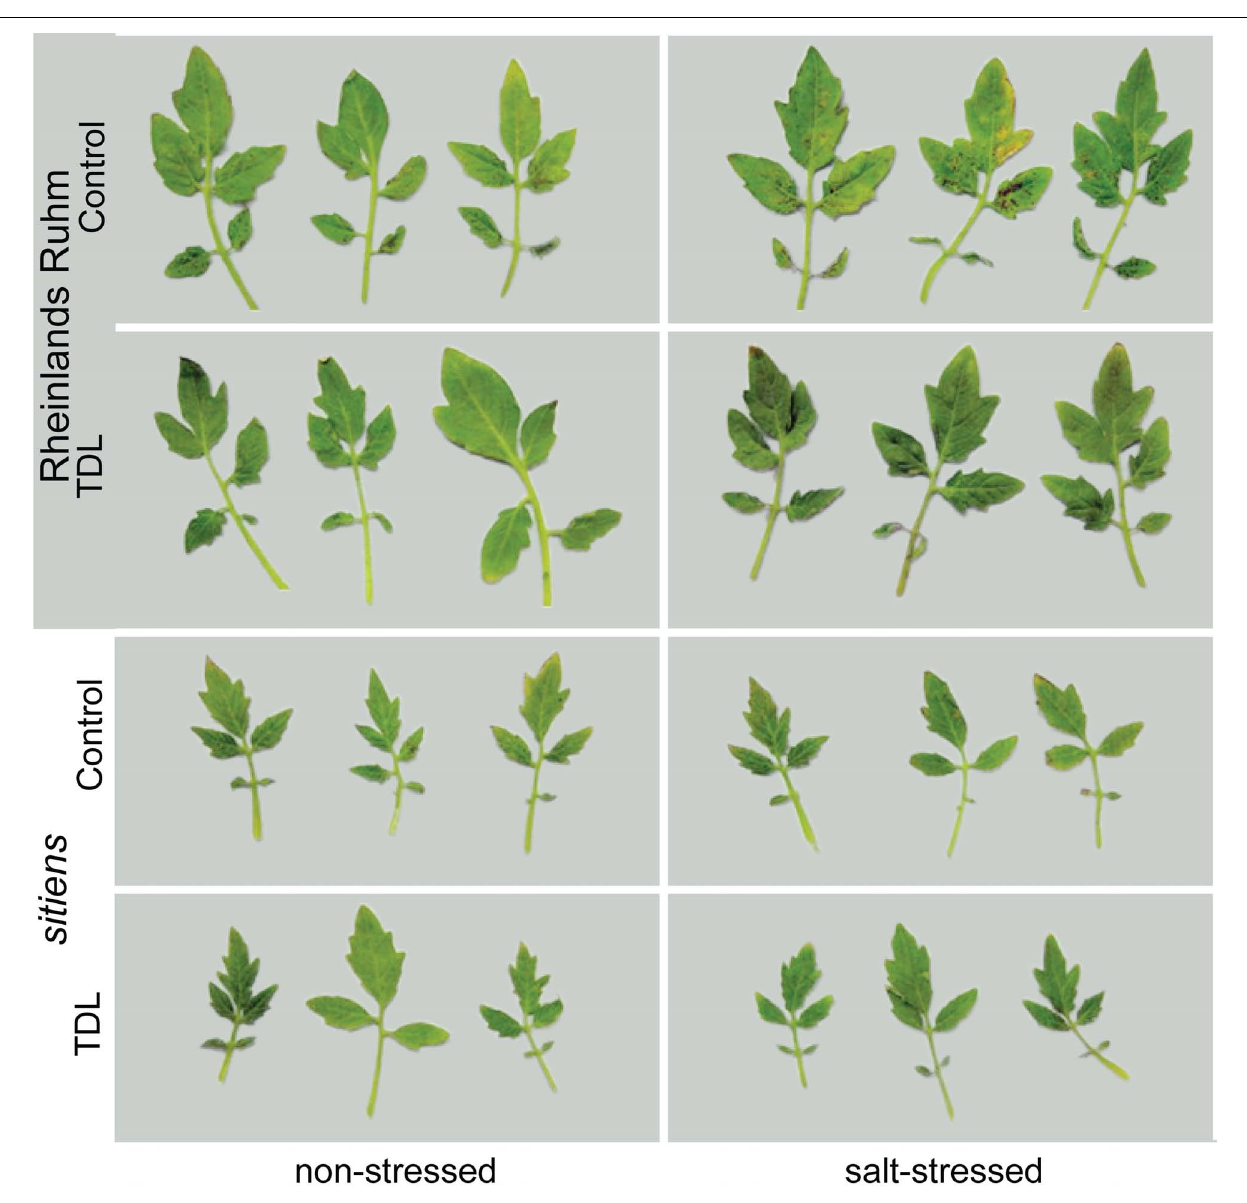
FIGURE 3 | Pseudomonas syringae pv. tomato colonization in background (”Rheinlands Ruhm”) and sitiens tomato leaves. Roots were pretreated withTDL for 7 days and then exposed for 18 h to salt stress (0.2 M NaCl/0.02 M CaCl 2 ). Shoots were dip-inoculated with a suspension of Pst adjusted to 10 7 cfu ml − 1 . Symptoms were photographed 4